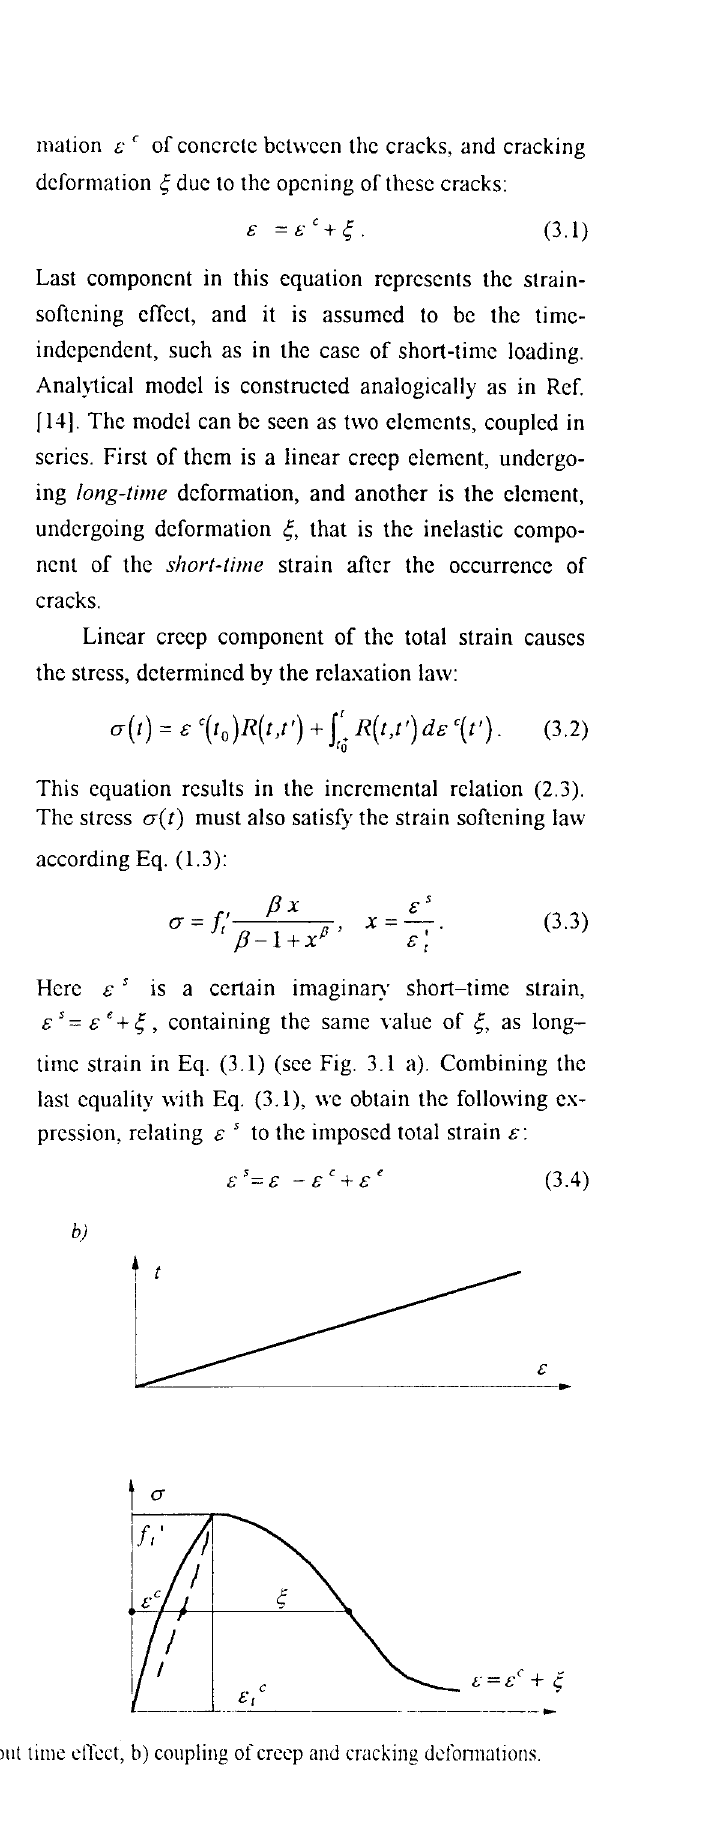
Fig. 3.1. Cracking behaviour of concrete: a) cracking without time c!Tcct, b) coupling of creep and cracking